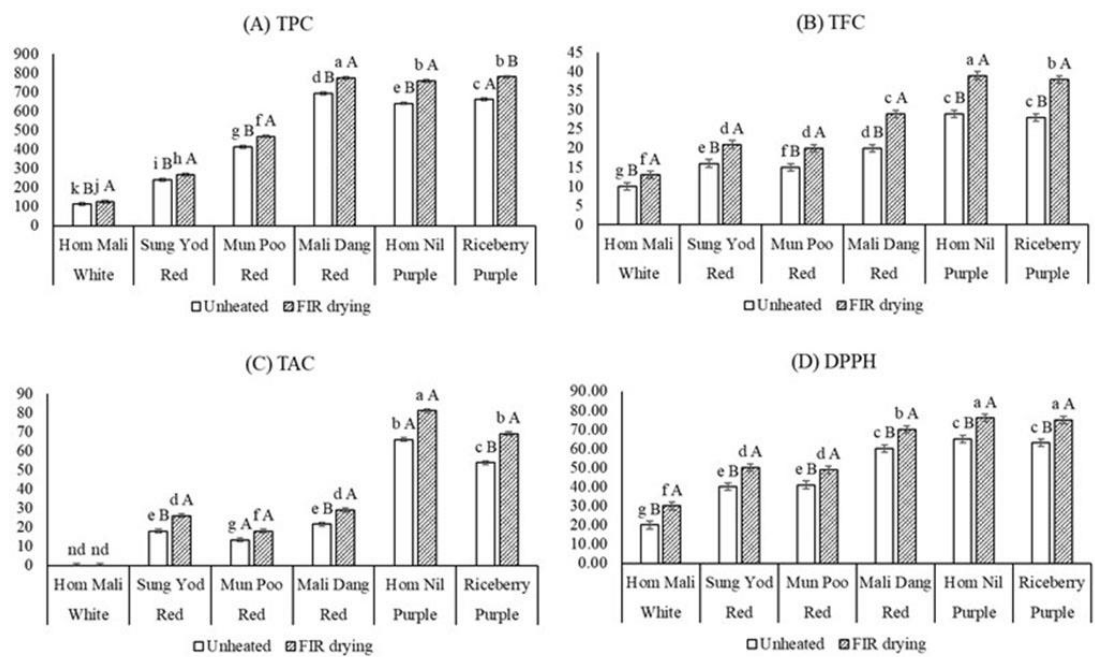
Figure 1. Effect of FIR drying on ( A ) total phenolic content; TPC (mg GAE/100 g DW), ( B ) total flavonoid content; TFC (mg RE/100 g DW), ( C ) total anthocyanin content (TAC) (mg CyGE/100 g) and ( D ) antioxidant capacity (DPPH) (%) of pigmented rice. Values are expressed as mean ± standard deviation ( n = 3). Means with different capital letters of unheated and FIR drying rice in the same rice variety as affected by different drying methods were significantly different at the level ( p < 0.05). Lowercase superscripts are used for comparison of all samples.